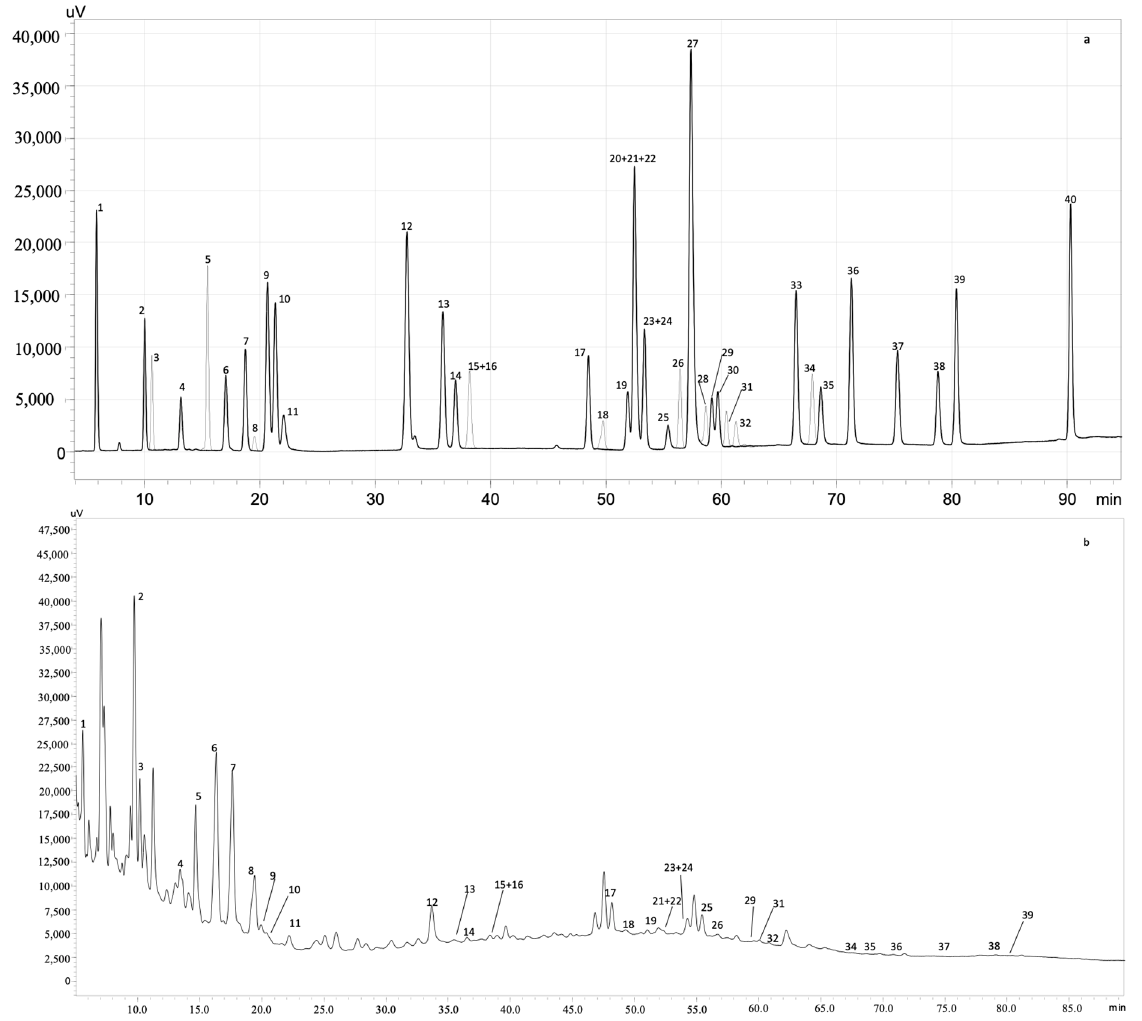
Figure 1. HPLC-PDA chromatogram monitored at 280 nm for a) polyphenol standard mixture of 5 mg/L and b) subcritical water extract obtained at 140 °C; peak identification: (1) gallic acid, (2) protocatechuic acid, (3) neochlorogenic acid, (4) ( + )-catechin, (5) caftaric acid, (6) caffeine, (7) chlorogenic acid, (8) 4- O -caffeyolquinic acid, (9) vanillic acid, (10) caffeic acid, (11) syringic acid, (12) ( − )-epicatechin, (13) p -coumaric acid, (14) trans -ferulic acid, (15) sinapic acid, (16) trans -polydatin, (17) naringin, (18) 3,5-di-caffeoylquinic acid, (19) quercetin-3- O -galactoside, (20) resveratrol, (21) quercetin-3- O -glucopyranoside, (22) rutin, (23) phloridzin, (24) ellagic acid, (25) 3,4-di- O -caffeoylquinic acid; (26) myricetin, (27) cinnamic acid, (28) quercitrin, (29) kaempferol-3- O -glucoside, (30) isorhamnetin-3- O -glucoside, (31) kaempferol-3- O -rutinoside, (32) isorhamnetin-3- O -rutinoside, (33) naringenin, (34) trans -epsilon viniferin, (35) quercetin, (36) phloretin, (37) tiliroside, (38) kaempferol, (39) apigenin and (40) chrysin.